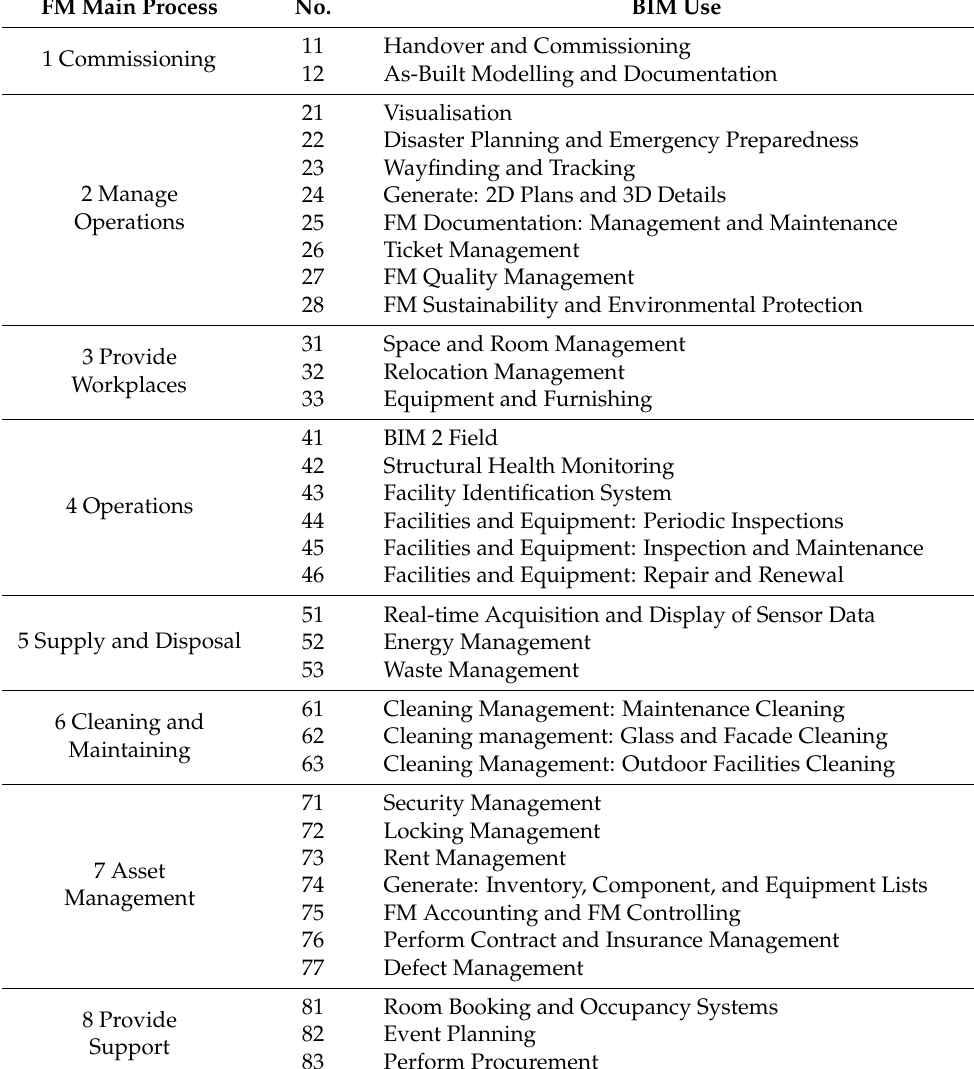
Table 3. Identified BIM uses for FM in